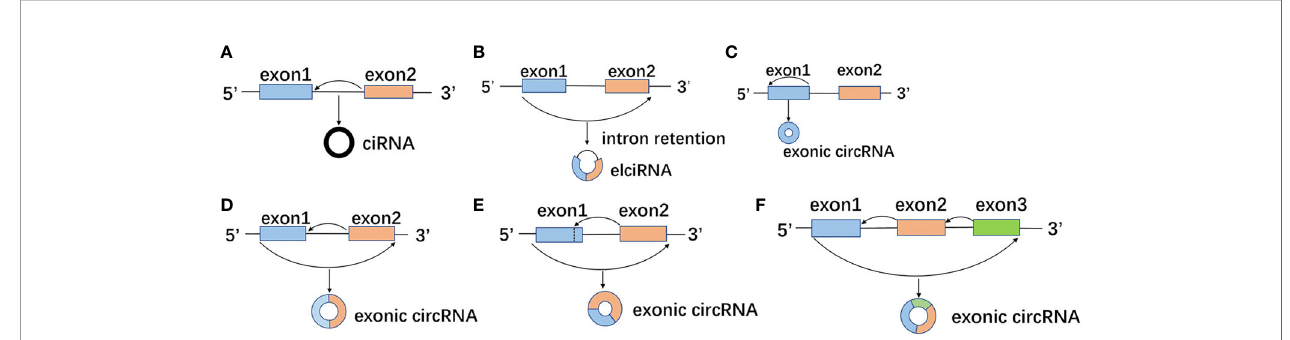
FIGURE 1 | Different splicing sites and compositions form different circRNAs. (A) The splicing sites of pre-mRNA during the formation of intron circRNA (ciRNA) by intron circularization. (B) The splicing sites of pre-mRNA during exon and intron cyclization to form exon-intro circRNA (EIciRNA). (C-F) The splicing sites of pre- mRNA in the process exon cyclization to form exonic circRNA